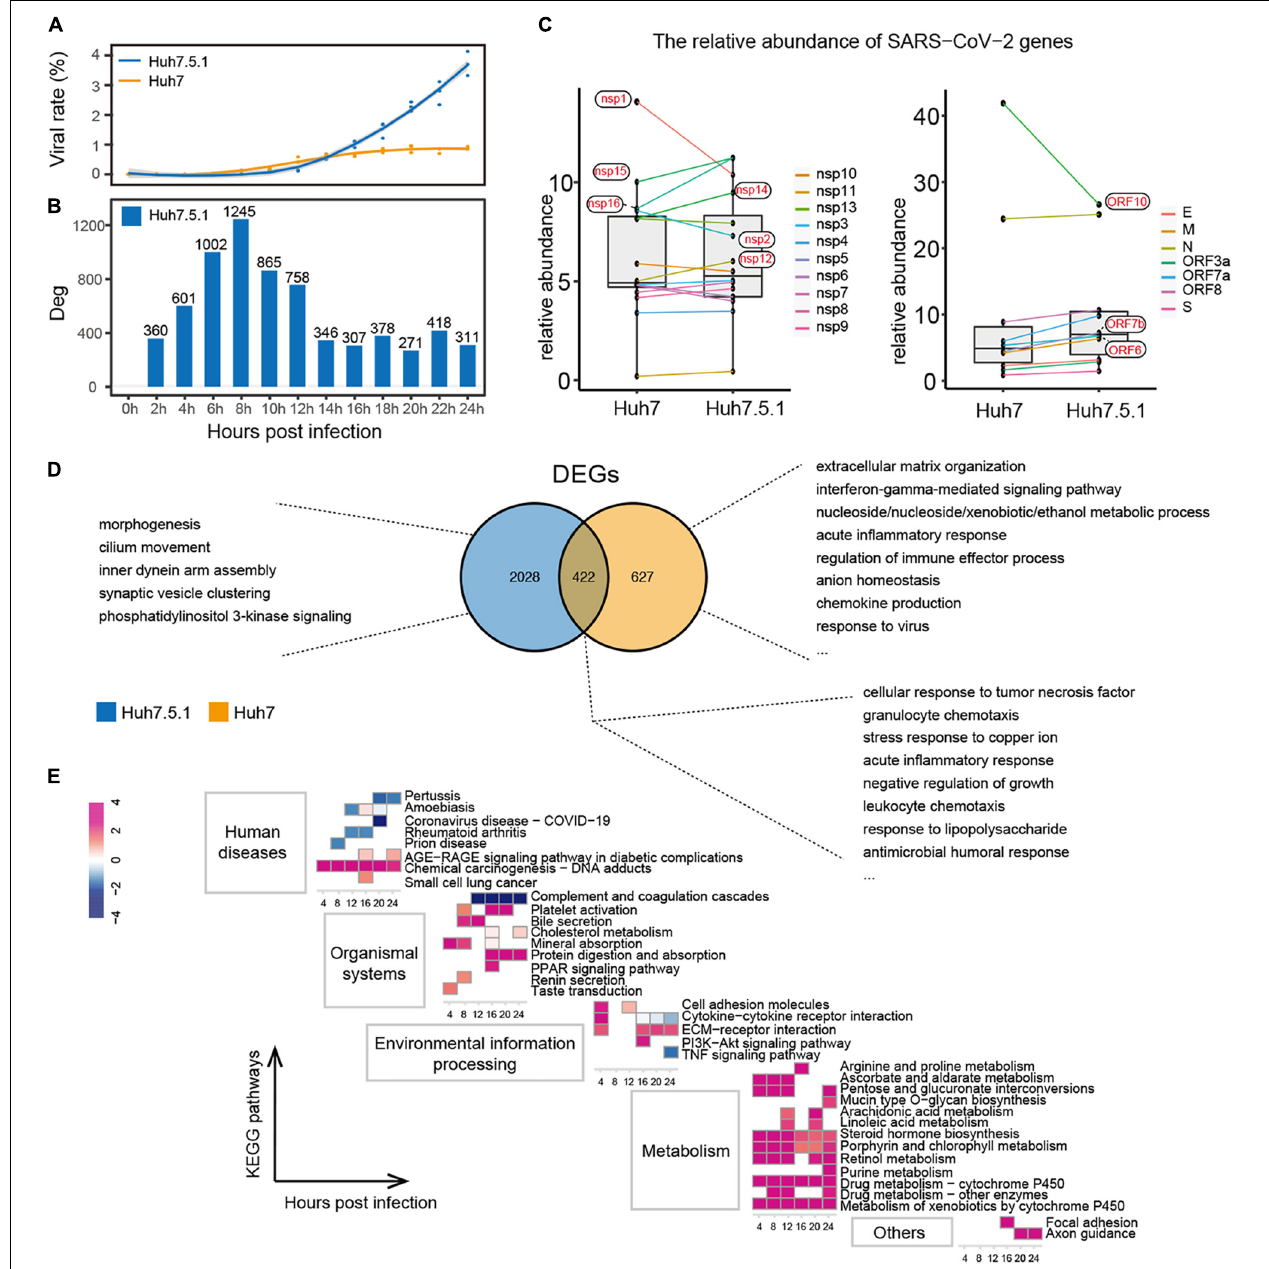
FIGURE 5 | Interaction of IFN+/– hepatocytes with SARS-CoV-2. (A,B) Proportion of SARS-CoV-2 (A) and distribution of DEG numbers (B) in Huh7.5.1 during infection. (C) Comparison of relative abundance of each viral gene in IFN+/– hepatocytes. (D) Functions of unique and shared DEGs within Huh7.5.1 and Huh7 cells. (E) Enriched pathways in Huh7.5.1 are shown along with corresponding Huh7 at each time point as a control. Colors represent z -score of the